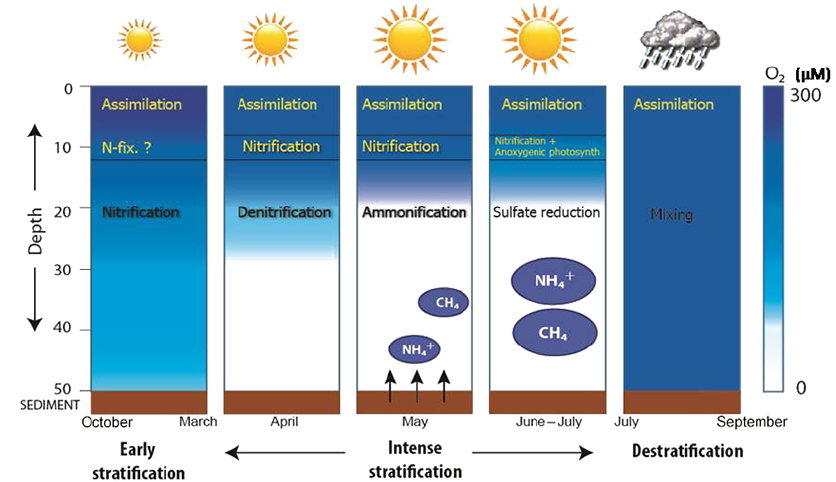
Figure 6. Schematic diagram depicting major biogeochemical processes taking place in the Tillari Reservoir over an annual cycle. This information is based on monthly sampling in the reservoir for several years (Shenoy et al., 2017).